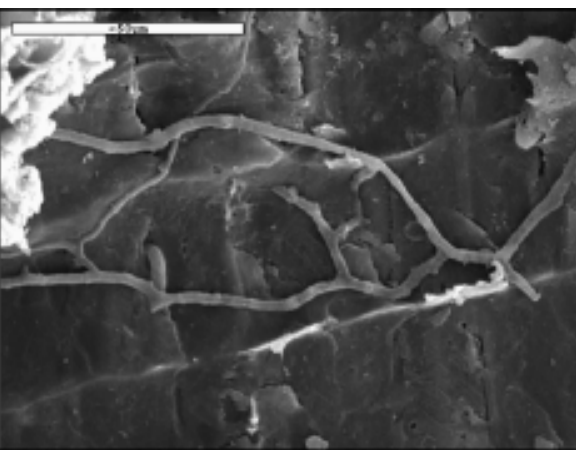
Fig. 3. Scanning electron micrograph of a longitudinal section of naturally infected rootstock Richter 110 ( (cid:1) 450), showing fungal mycelium on the inside of a xy- lem